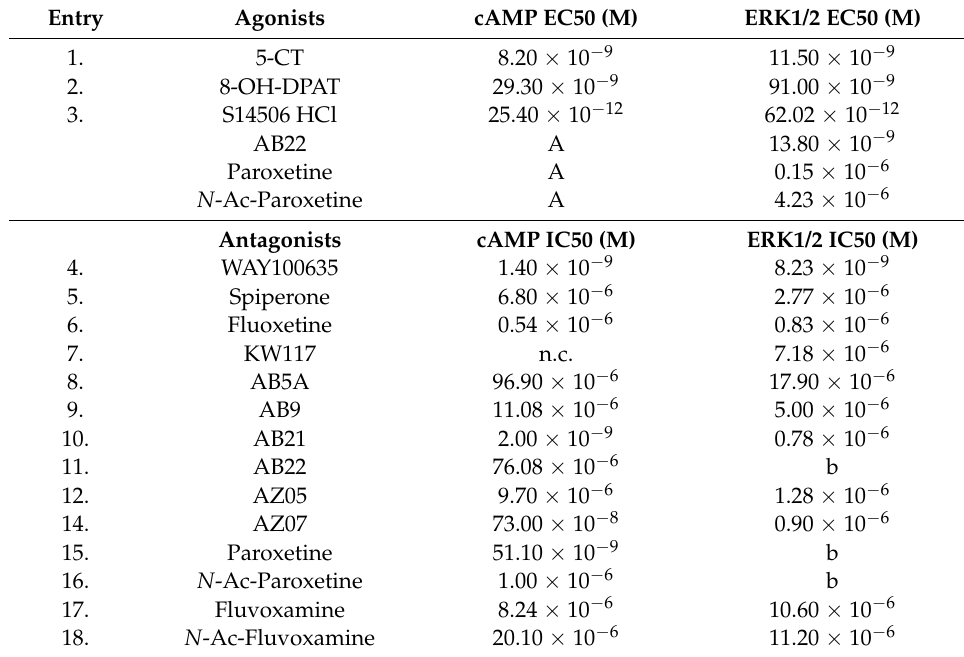
Table 3. Functional activity of new and classic ligands of 5-HT 1A receptor in HEK293 cells that overexpress the 5-HT1AR